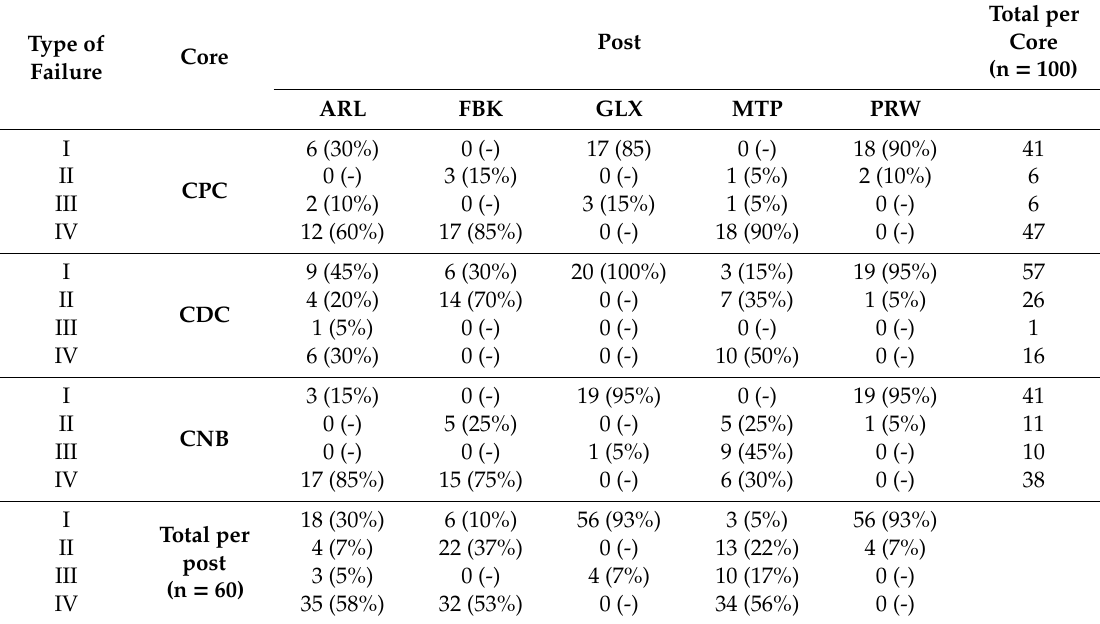
Figure 10. BE LV-SEM image of a fractured MTL post, ( a ) with details ( b ) of non-uniformly distributed fibers (a: 40 × , bar = 1 mm, b: 140 × , bar = 300 µ m). Table 4. Results of failure mode analysis.